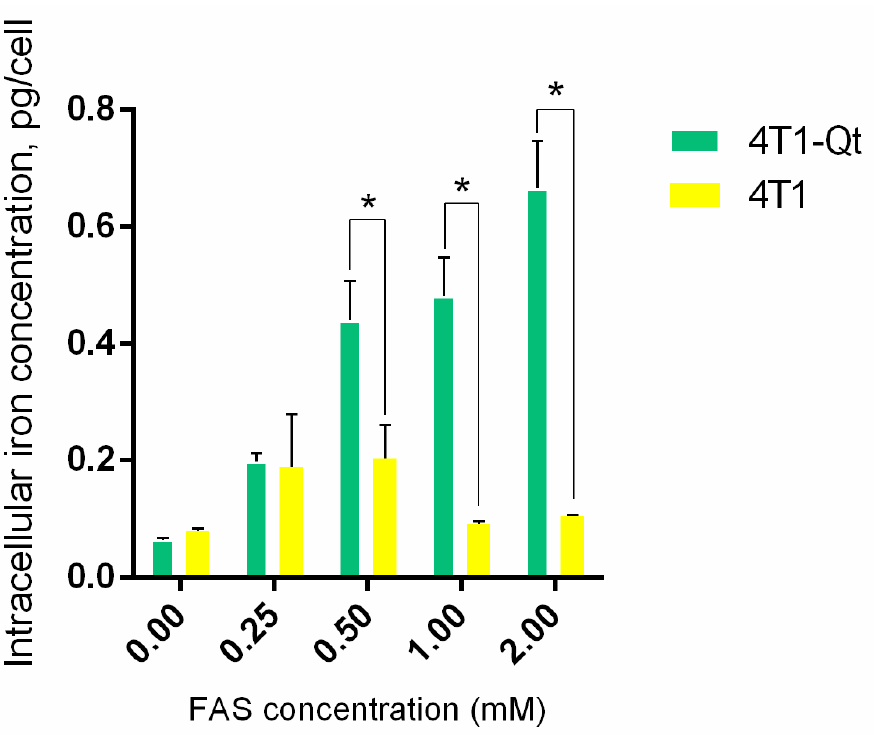
Figure 5. Cellular iron content in 4T1 and 4T1-Qt cells quantified by AES spectrometry. The data are shown as the mean + S.D of three independent experiments, p values were calculated using a one-tailed t -test, assuming unequal variances (* indicate p -value < 0.05).